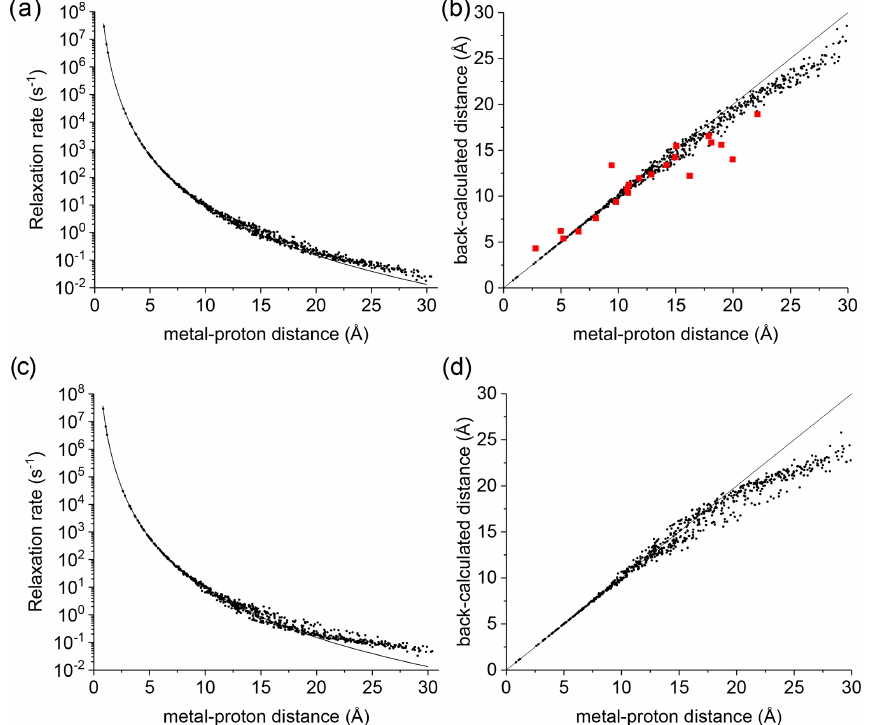
Figure 1. (a) Apparent paramagnetic relaxation rates calculated at 500MHz for Cu 2 + -plastocyanin protons. The line indicates the rates predicted with the Solomon equation. (b) Agreement between metal–proton distances as measured in the PDB 2GIM structure and back- calculated from the predicted R 1 . (c, d) The same calculations are performed assuming fixed positions for methyl protons. The red points in panel (b) refer to the distances back-calculated from the experimental data (Ma et al.,